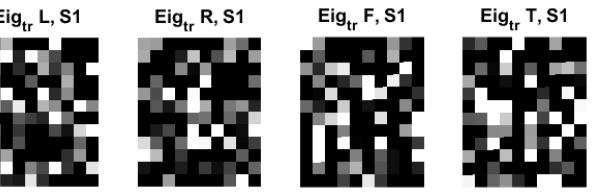
Figure 7. An original eigenface images of subjects for training data for 4 classes: left, right, feet, and tongue after whitening (12 × 10: = 30 × 4) in